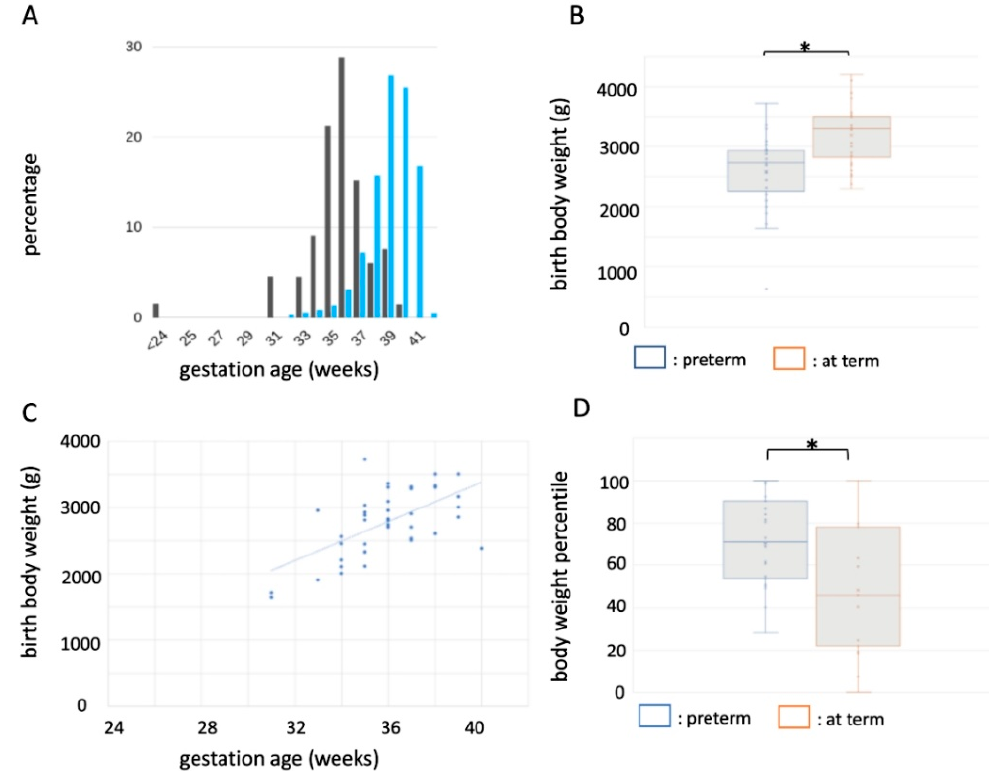
Figure 1. Preterm birth characteristics of MVID. ( A ) Distribution of gestational ages in MVID (black bars) versus population (blue bars). ( B ) Box-and-whisker plot showing average and mean body weights in MVID patients born preterm (blue) and at term (orange). ( C ) Correlation between gestational age and body weight in MVID. ( D ) Box-and-whisker plot showing average and mean body weight percentiles in MVID patients born preterm (blue) and at term (orange). *: p < 0.05. For exact p values see text.